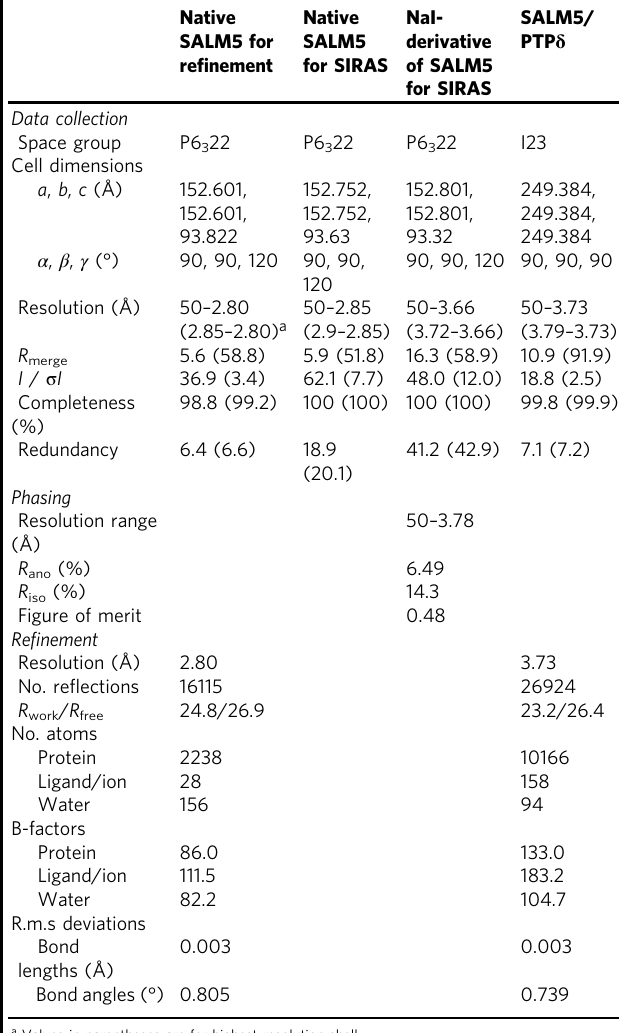
Table 1 Data collection, phasing, and re fi nement statistics (SIRAS) Native SALM5